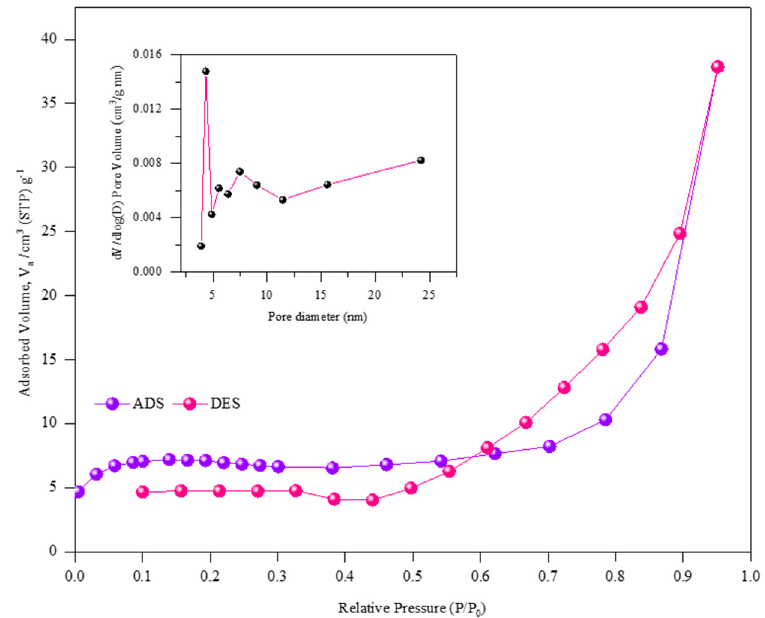
Figure 5. N 2 adsorption/desorption isotherm and BJH pore-size distribution (inset) curve of the calcined δ− MnO 2 sample.